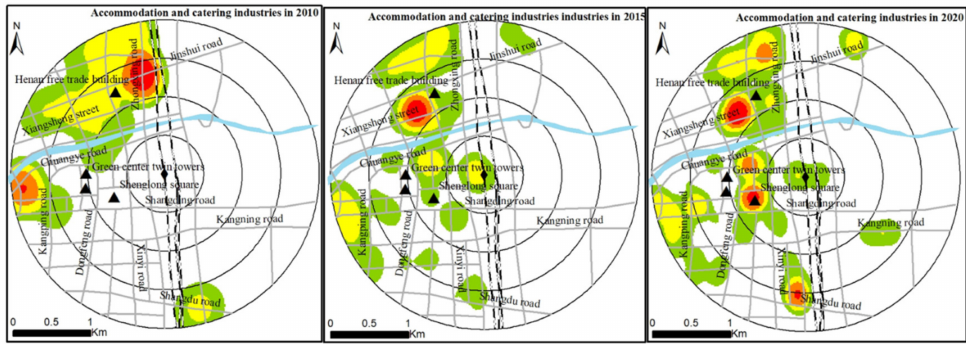
Figure 5. Kernel density analysis of the accommodation and catering industries.